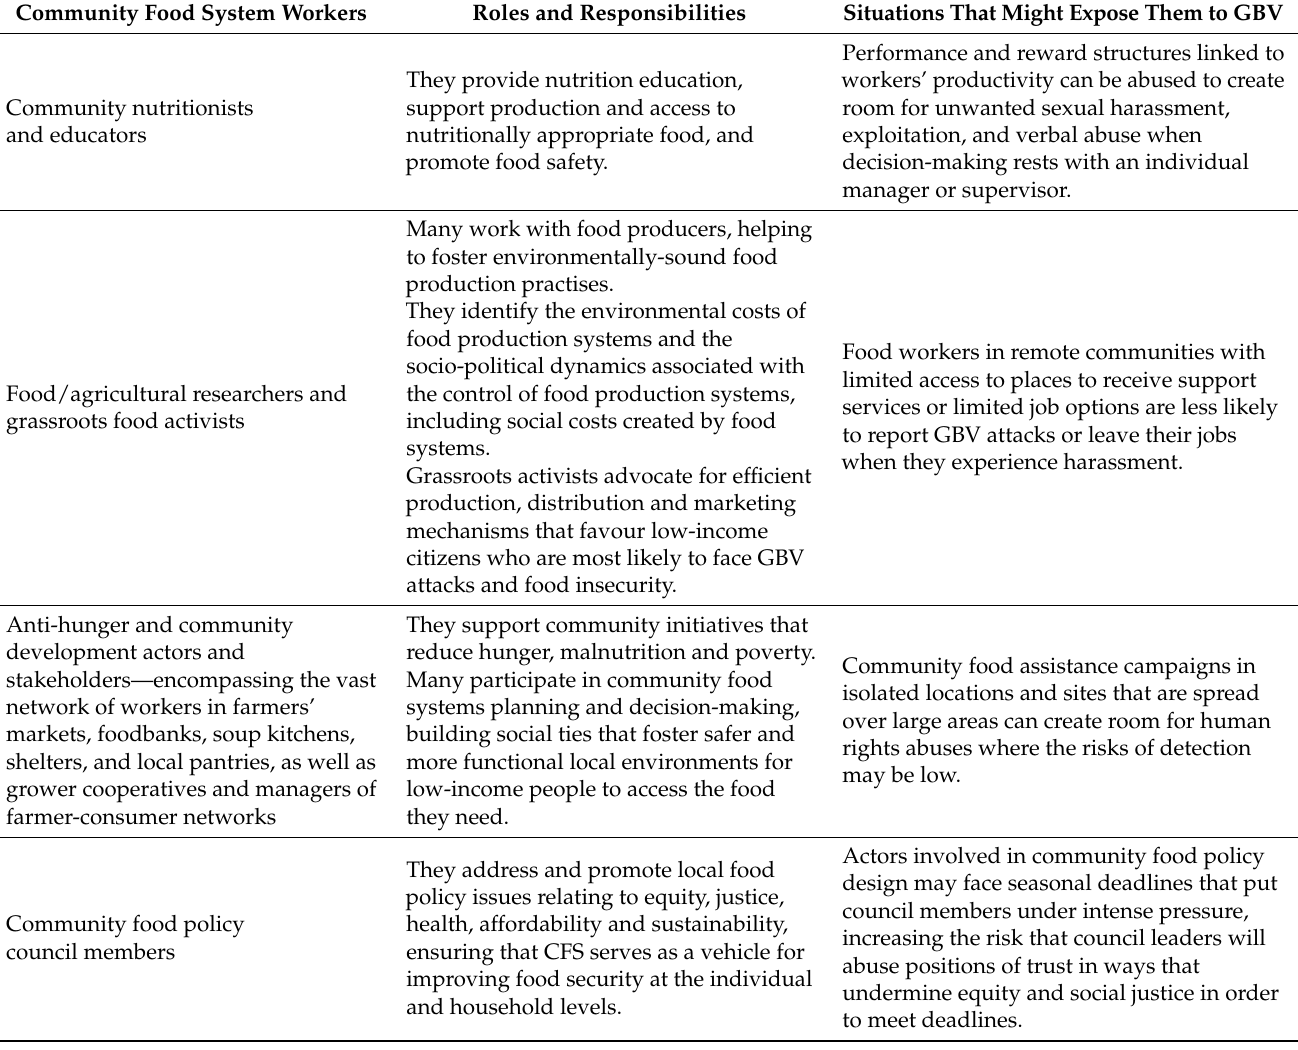
Table 3. The community food system workers, their roles, and situations exposing them to